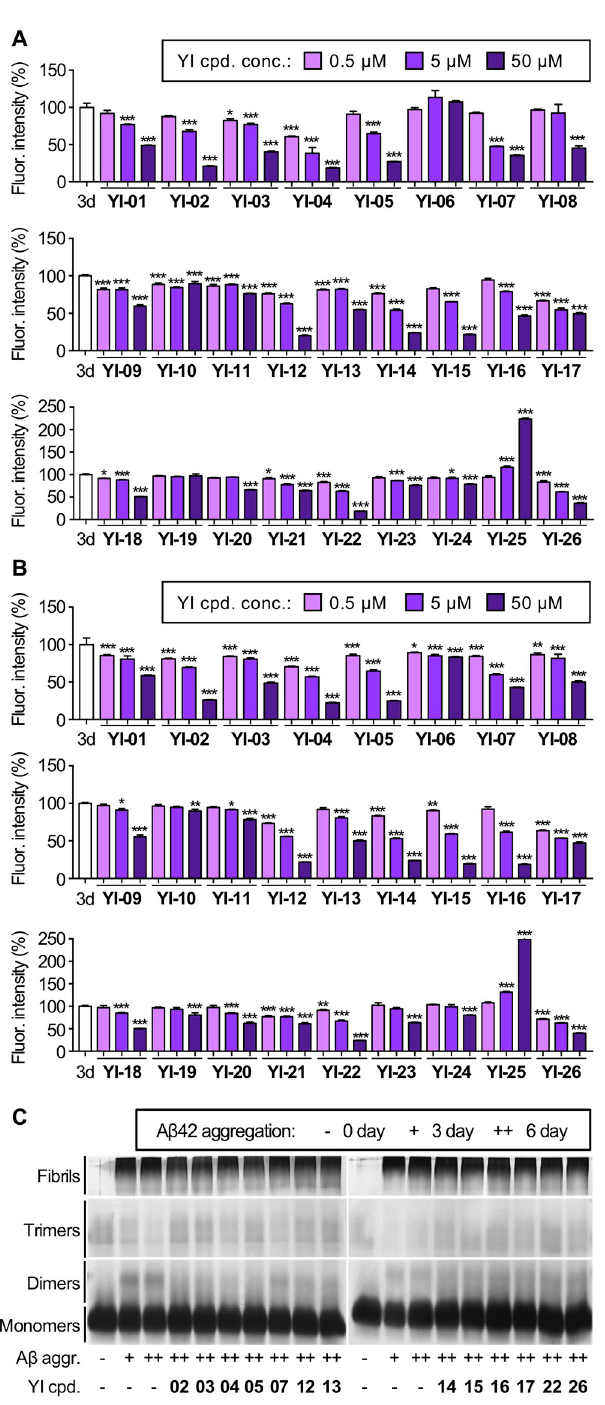
Fig 2. In vitro assays to evaluate anti-amyloidogenic properties of indolizine-derived YI compounds. (A) A β aggregation inhibition test by ThT assay. A β 42 (50 μ M) was incubated with or without YI compounds (0.5, 5, 50 μ M) for three days. (B)A β aggregates dissociation test by ThT assay. A β 42 aggregates (50 μ M, 3-day pre-aggregation) were incubated with or without YI compounds (0.5, 5, 50 μ M) for additional three days. (C) SDS-PAGE with PICUP and silver staining for disaggregated A β (50 μ M) with the incubation of YI compounds (250 μ M). Sizes of A β species according to the protein size markers are monomers (5 kDa), dimers (10 kDa), oligomers (15 to 75 kDa), and larger aggregates or fibrils (embedded at the top of the gels). Fluorescent intensities of all samples were normalized to 3-day A β aggregates data (100%). Denormalized data of ThT assay (S1 Fig) and whole gel images are shown in the (S2 Fig). Abbreviations: 3d = 3-day incubation of A β ,– = A β monomer, + = 3-day incubation of A β , ++ = 3-day pre-incubation